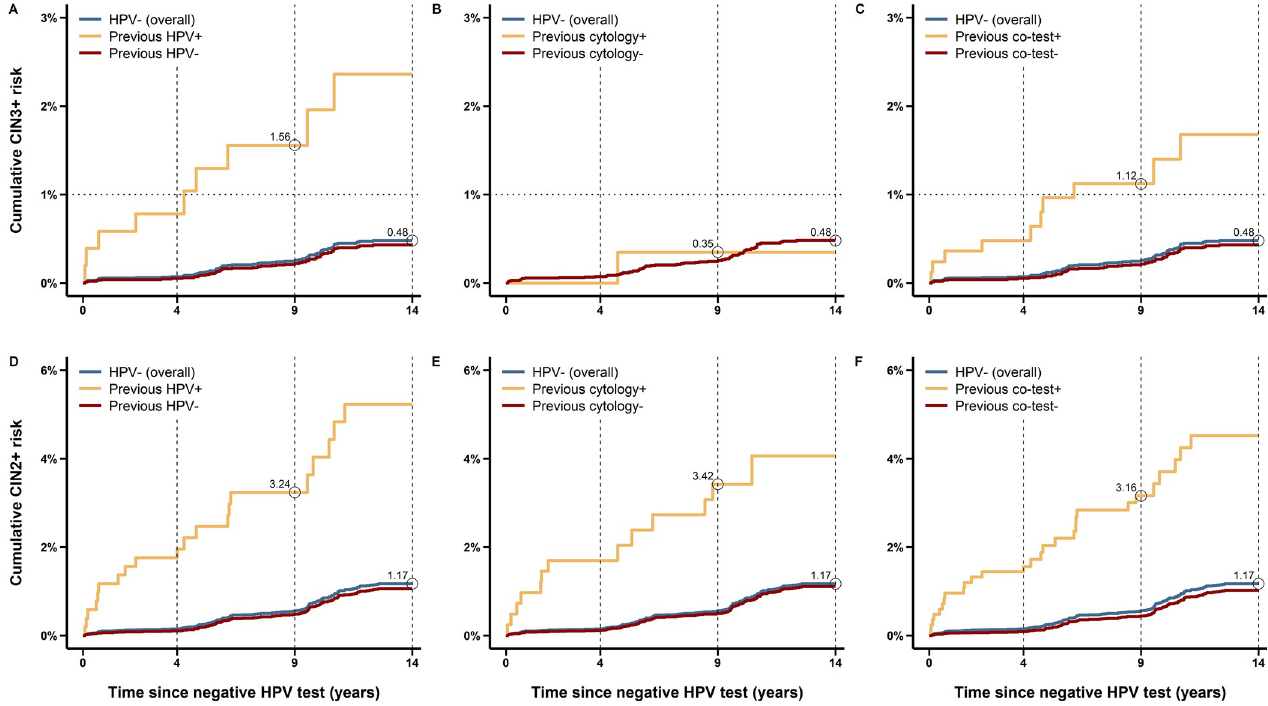
Fig 2. Absolute risks of CIN3+ and CIN2+ among HPV–negative women (pooled study groups) stratified for previous test result, after up to 3 screening rounds (14 years). Panels (A) to (C) refer to endpoint CIN3+ ((A) by previous HPV test, (B) by previous cytology test, (C) by previous co-test) and include a dotted line at 1% CIN3+ corresponding to the informal Dutch threshold for the next screening time point; panels (D) to (F) refer to endpoint CIN2+ ((D) by previous HPV test, (E) by previous cytology test, (F) by previous co-test). Values embedded in the plots represent the 14-year risk among HPV–negative women (overall; blue line) and the 9-year risk among HPV–negative women with a previous positive test (yellow line). In panel (B), the blue line is not visible due to the overlap with the red line. CIN2/3+, cervical intraepithelial neoplasia grade 2/3 or worse; HPV, human papillomavirus.